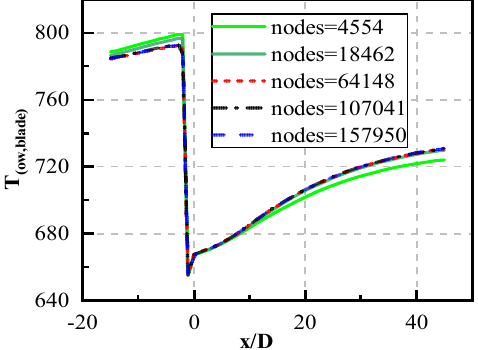
Figure 3. Mesh Figure 3. Mesh independence.